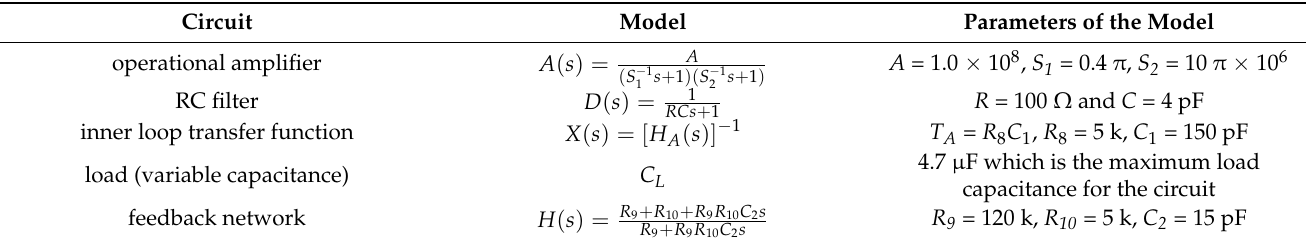
Figure 20. The control block diagram of the power amplifier using general operational amplifiers. Table 2. The parameters of the control block